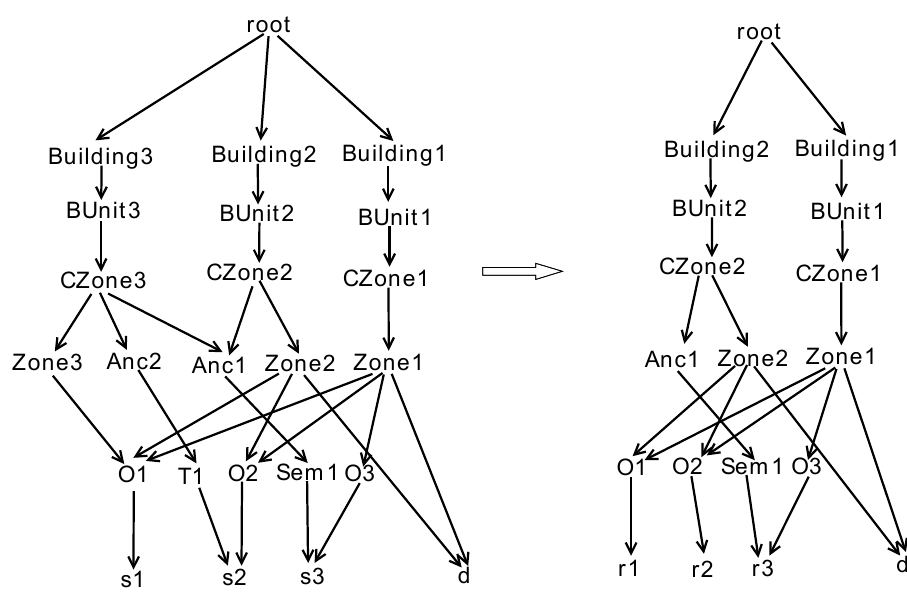
Figure 7. Procedure of creating parse forest by using bottom-up methods. (a) procedure of constructing first parse tree (b) procedure of constructing second parse tree (c) procedure of constructing third parse tree.